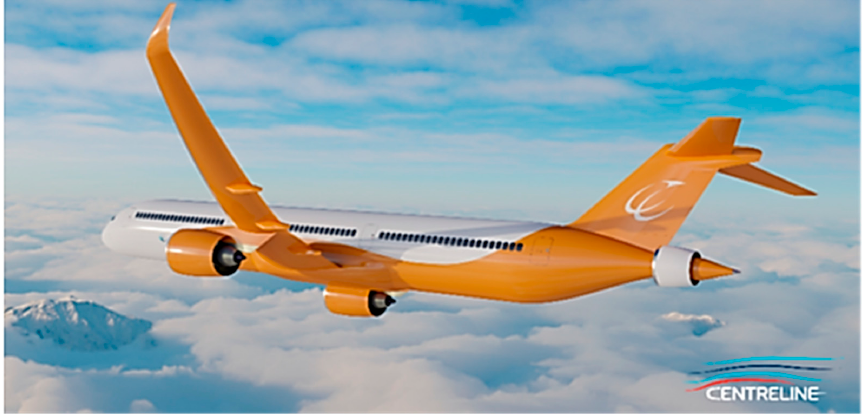
Figure 14. Turbo-electric propulsive fuselage aircraft design. Reprinted with permission from [147]. 2021, MDPI.